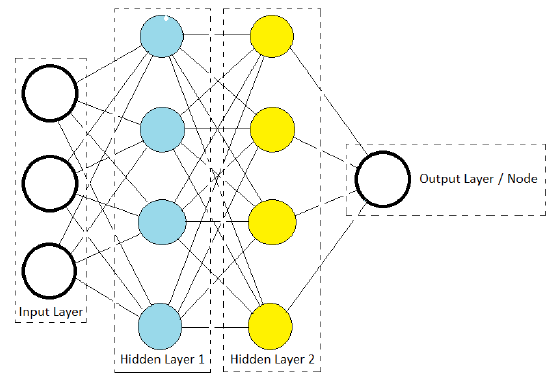
Figure 4. Representation of a generic neural network